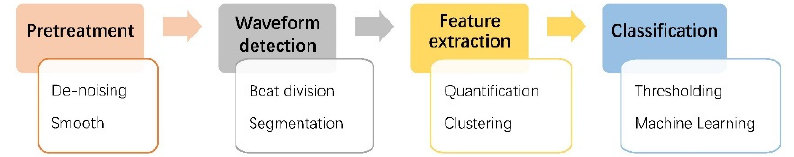
Figure 4. Traditional computer-aided methods for the diagnosis of